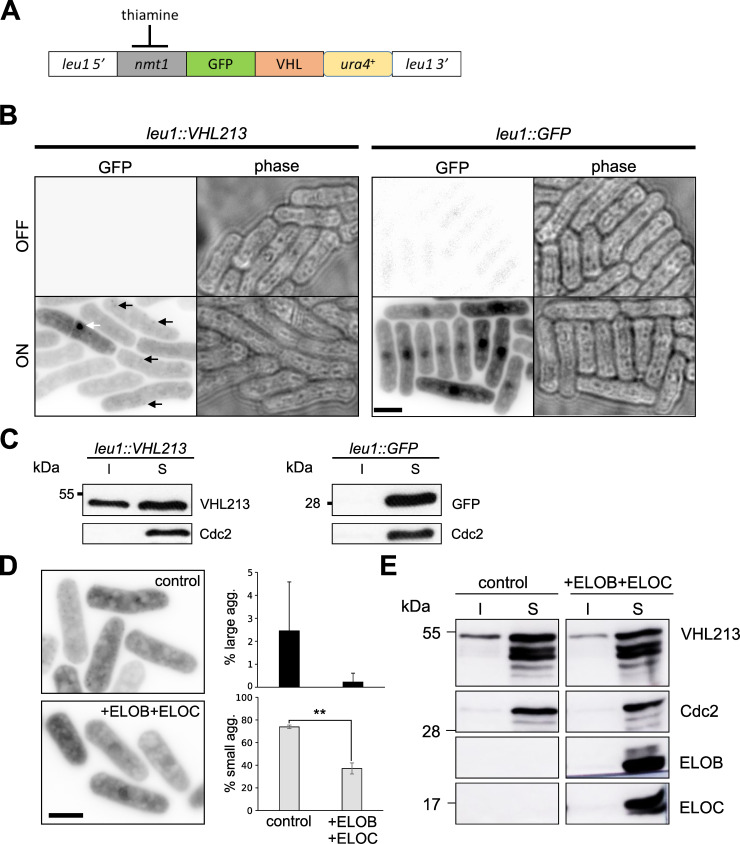
A conditional expression system to produce GFP-pVHL213 in fission yeast.A) Scheme of the integration cassette GFP-pVHL213 at the leu1 locus, GFP-pVHL213 is under the thiamine-repressible promoter nmt1. B) Reversed fluorescent (left) or phase contrast (right) images of leu1::VHL213 and leu1::GFP cells in the OFF (upper panels) or ON (lower panels) conditions. White and black arrows depict large and small aggregates, respectively. C) Western blot analysis of GFP-pVHL213 or GFP expression (ON condition) in leu1::VHL213 and leu1::GFP cells, respectively: Soluble (S) and Insoluble (I) fractions are shown. Cdc2 was used as a loading control. D) Aggregation of GFP-pVHL213 was compared between leu1::VHL213 cells transformed with empty control vectors (v1/v2) or v1-ElonginB and v2-Elongin C (+ELOB+ELOC) expressing plasmids. Left: reversed fluorescent images and right: histograms representing the percentage of large (upper panel) and small (lower panel) aggregate-containing cells (mean±s.d. from three independent experiments; **, p<0.01, Student t test). E) Western blot analysis of GFP-pVHL213 (VHL213), Elongin B (ELOB), Elongin C (ELOC) in cells: Soluble (S) and Insoluble (I) fractions are shown. Cdc2 was used as a loading control. Bars: 5 μm.